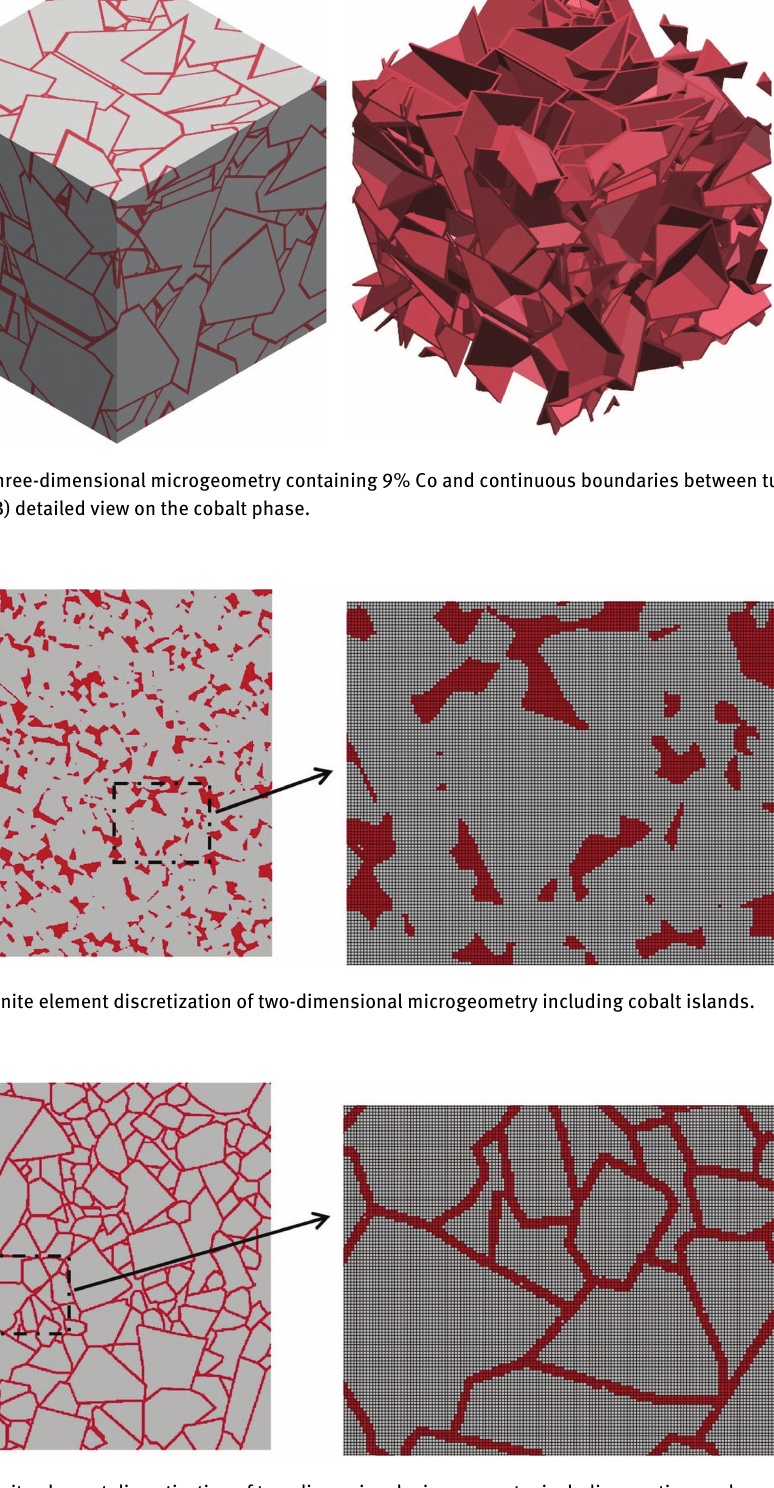
Figure 9: Finite element discretization of two-dimensional microgeometry including continuous boundaries between tungsten carbide